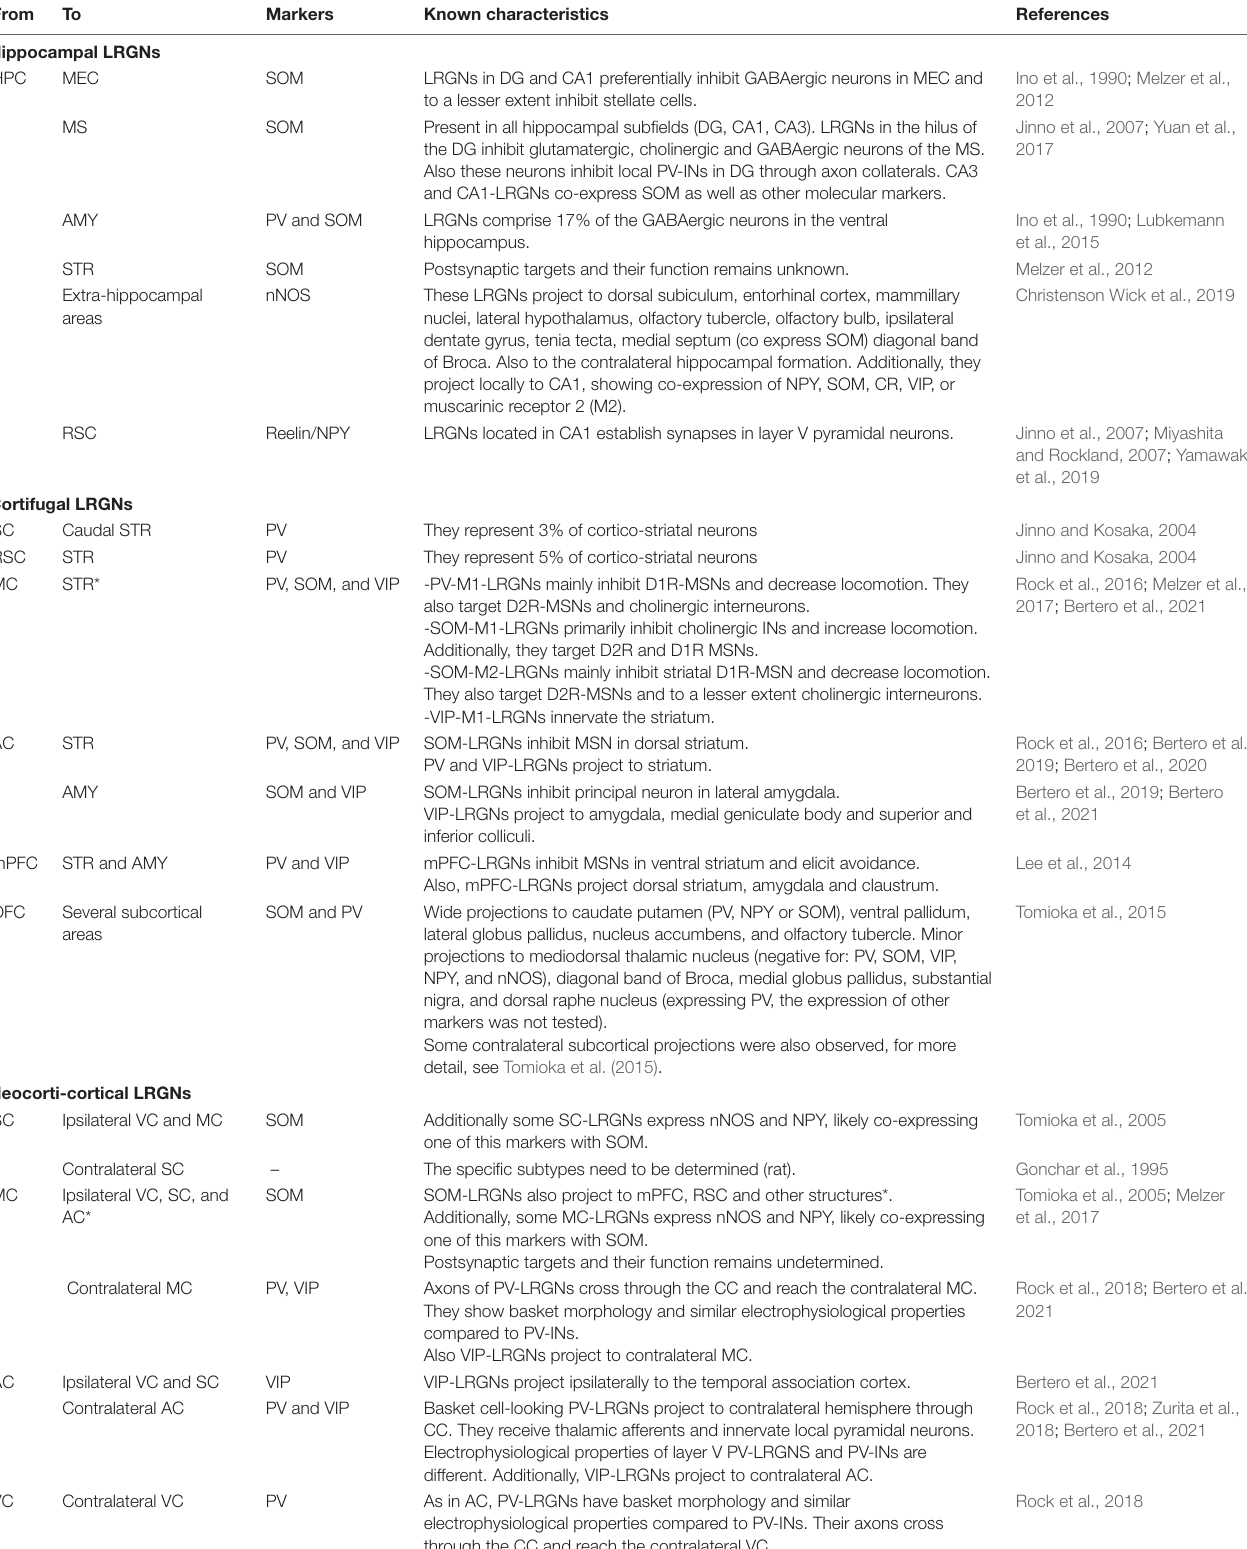
TABLE 2 | Cortical long-range GABAergic neurons (LRGNs). From